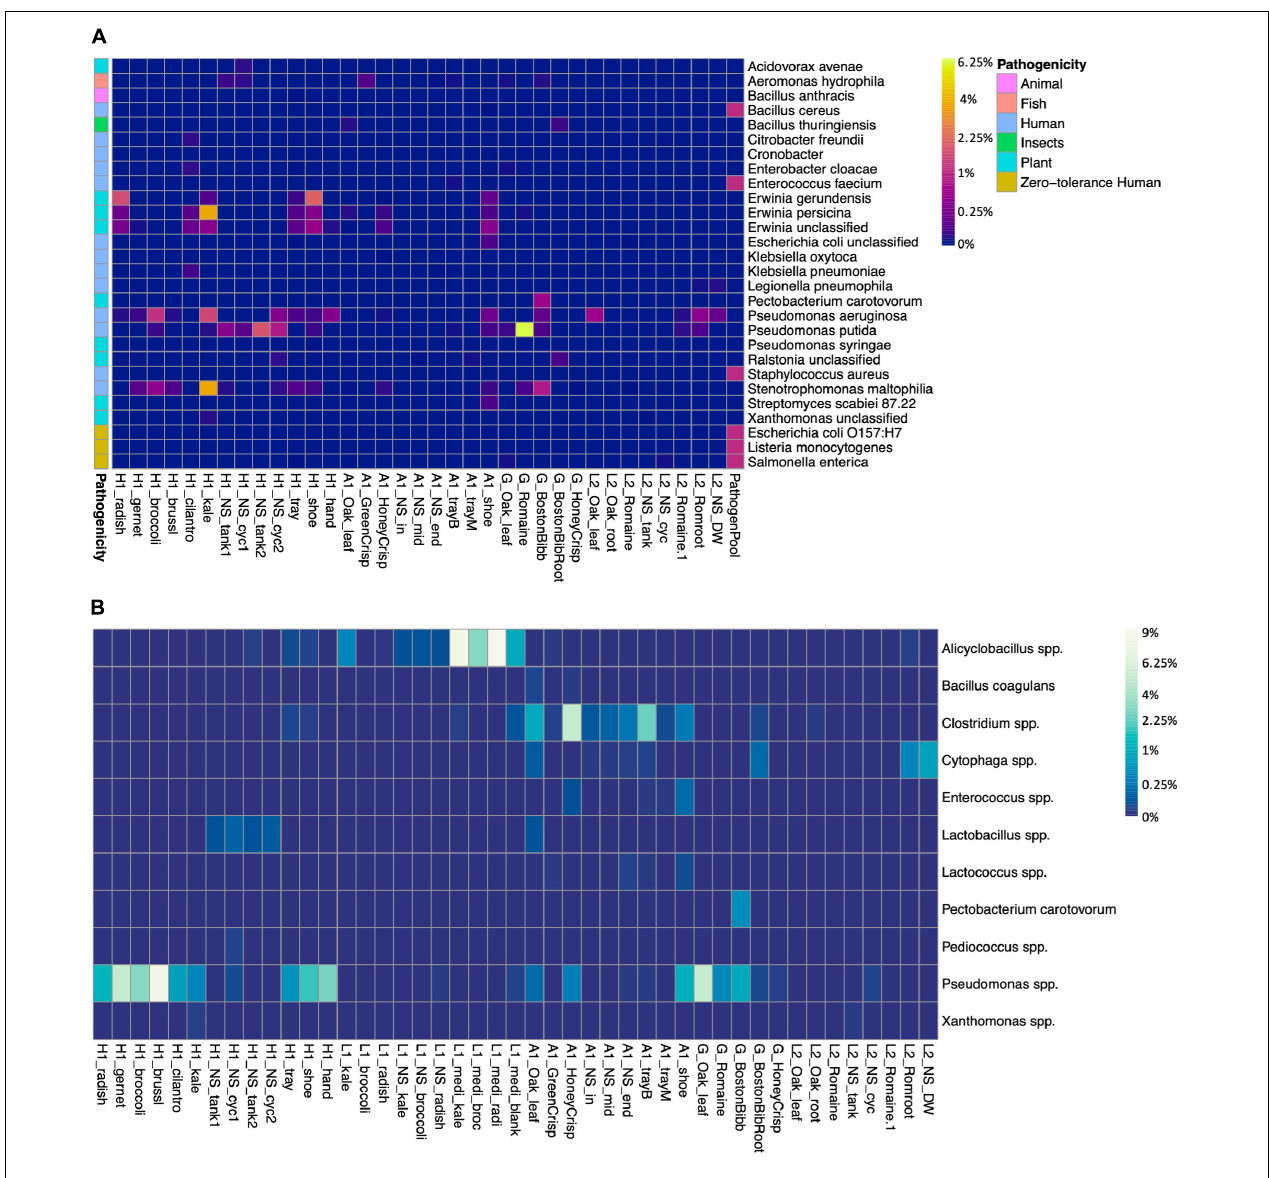
FIGURE 4 | Presence of pathogens and bacteria of interest, and spoilage species in samples. (A) Presence of pathogens and bacteria of interest. Colored blocks on the left side indicate the potential pathogenicity toward animal, fish, human, insects, or plants. L1 samples are free of any listed strains, thus not shown in the graph. (B) Presence of spoilage bacteria species in samples, the spoilage-related ASVs were grouped at the species level. The heatmap color scale is in square root